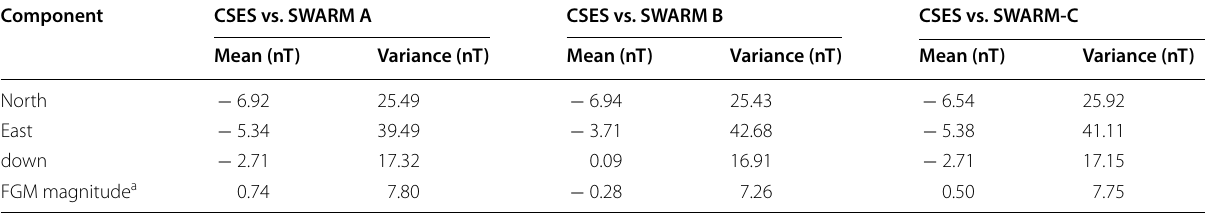
a The FGM magnitude is calculated with three vector components after correction